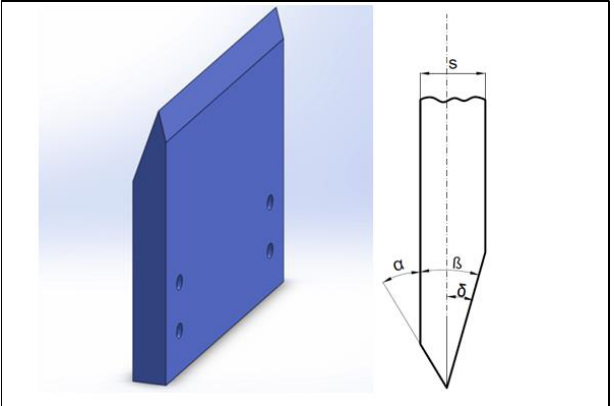
Figure 2. Experimental delimbing knife.